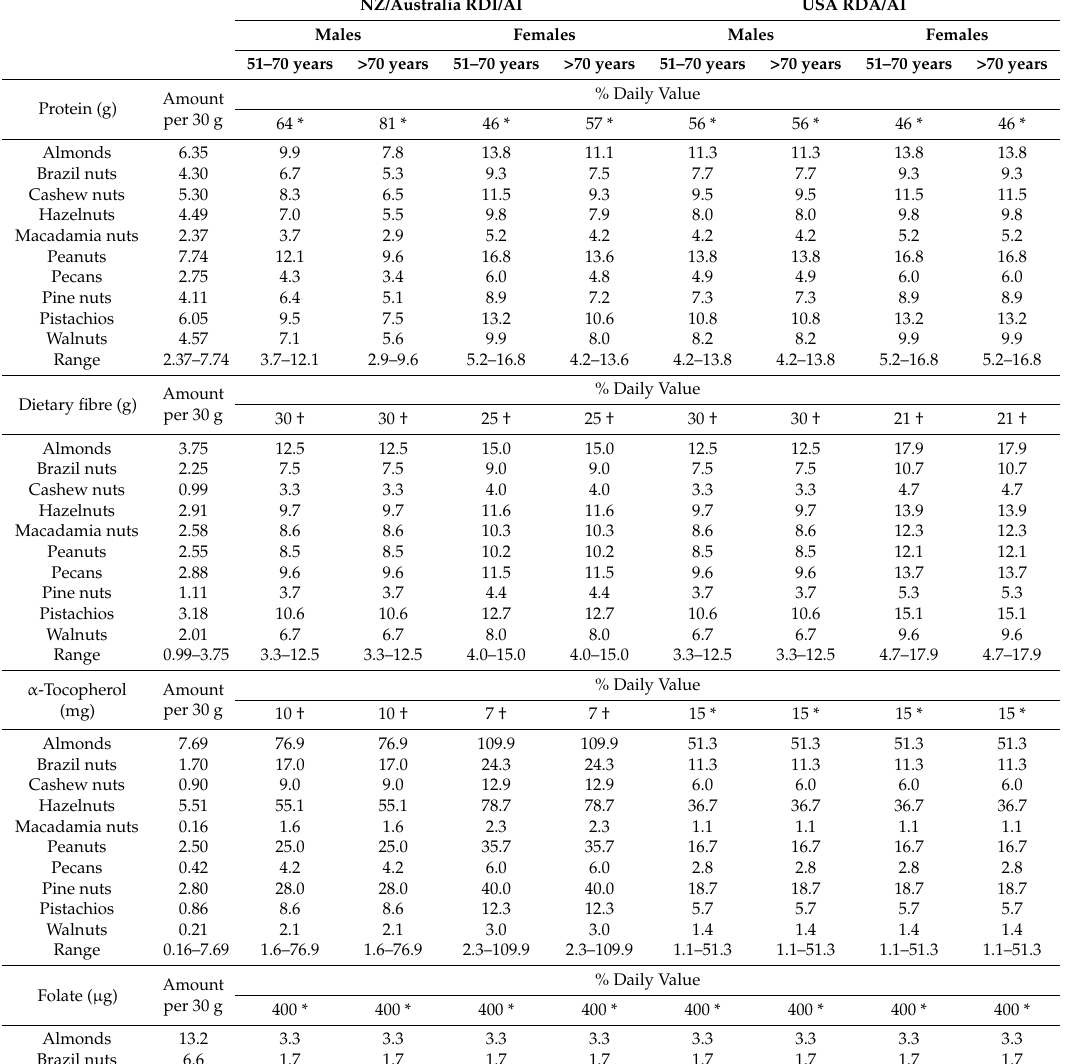
Table 1. The contribution of different nuts to the Recommended Daily Intake (RDI) or Recommended Dietary Allowance (RDA), and Adequate Intake (AI) from New Zealand/Australia and the